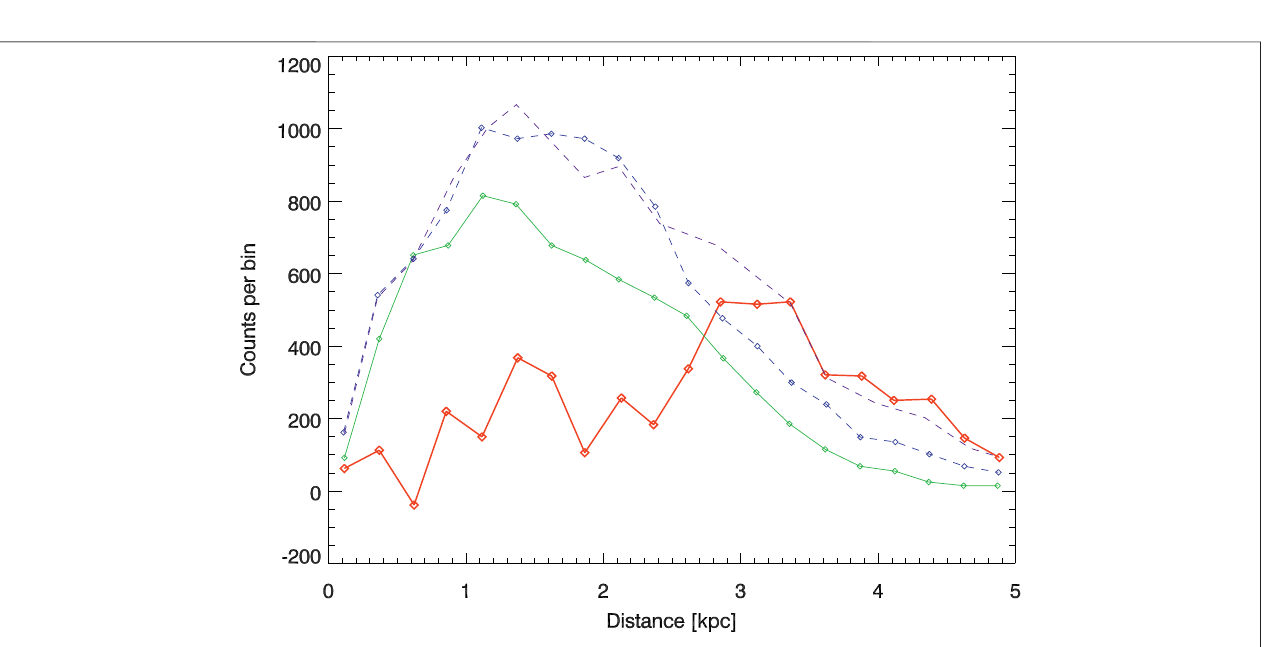
FIGURE 4 | Star counts as a function of distance from the Sun, for 3 close Galactic longitudes, ℓ (cid:1) 30.5 ° (green), 32.0 ° (violet), and 33.5 ° (blue). The red curve represents the counts ℓ 32 after subtraction of the mean of the other two line-of-sights, ( ℓ 30.5 + ℓ 33.5 )/2. The counts ofthe red line where multiplied by 2 for better visibility.